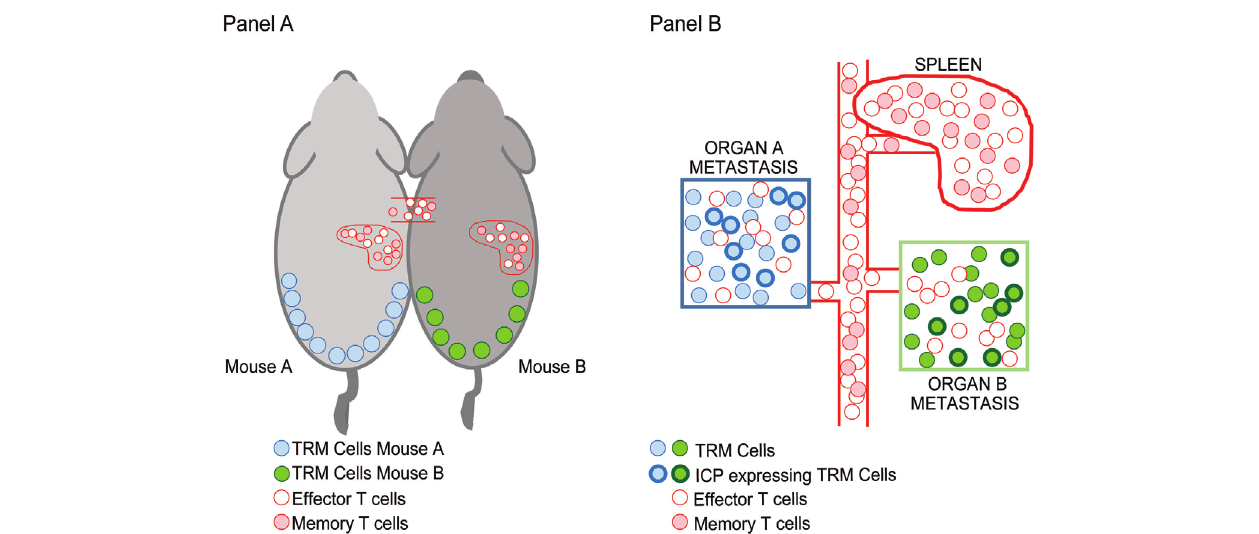
FiGURe 1 | Inter-lesional heterogeneity in metastatic cancer and biology of tissue-resident memory (T RM ) cells. T RM T cells were identified in mice based on their restriction to non-lymphoid tissues and lack of recirculation. This was demonstrated using parabiotic mice (A) that share the same systemic circulation. Figure shows that T RM cells in the skin (blue/green) do not equilibrate between mice, while other effector/memory T cells (pink/red) do. In the setting of advanced cancer in humans (B) , individual metastatic lesions can be observed in diverse tissues that share systemic circulation analogous to the parabiotic mice. Sequencing of T cell receptors (TCRs) in individual lesions from the same patient demonstrated that dominant TCRs in each of the lesions were non-overlapping and that the inter- lesional heterogeneity of TCRs exceeded differences in neoantigens. Importantly, T RM cells were the major contributors to this heterogeneity suggesting that they do not equilibrate between lesions as in parabiotic mice in Ref. (25). A subset of T RM cells that infiltrate these tumors express inhibitory immune checkpoints such as PD1 (shown by bolded